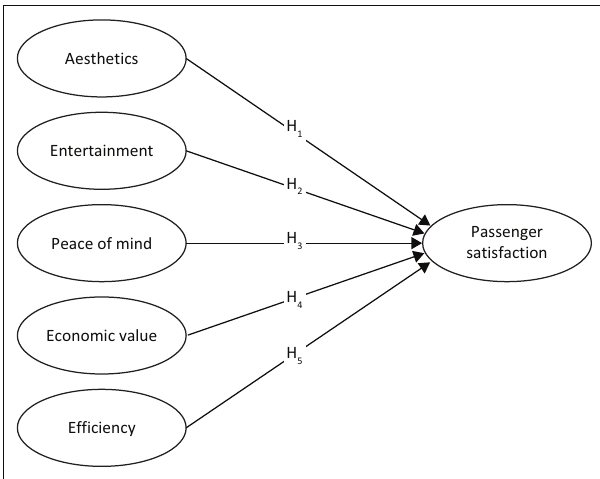
FIGURE 1: Hypothetical